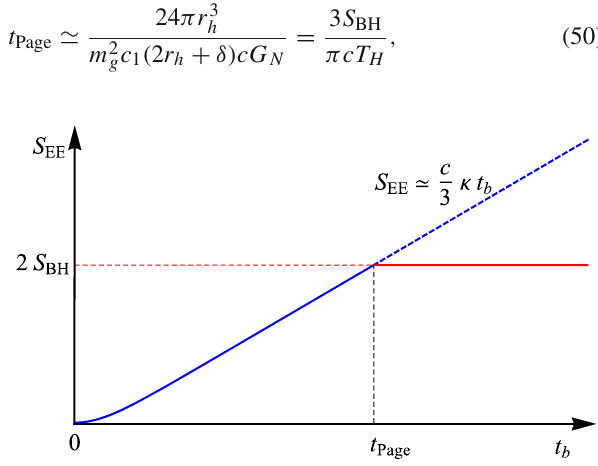
Fig. 5 The Page curve for the neutral black hole in massive gravity. The solid and dashed blue lines refer to the time evolution of the entan- glement entropy at the early times and the late times without the island, respectively. The solid red line stands for the entanglement entropy at the late times in the presence of an